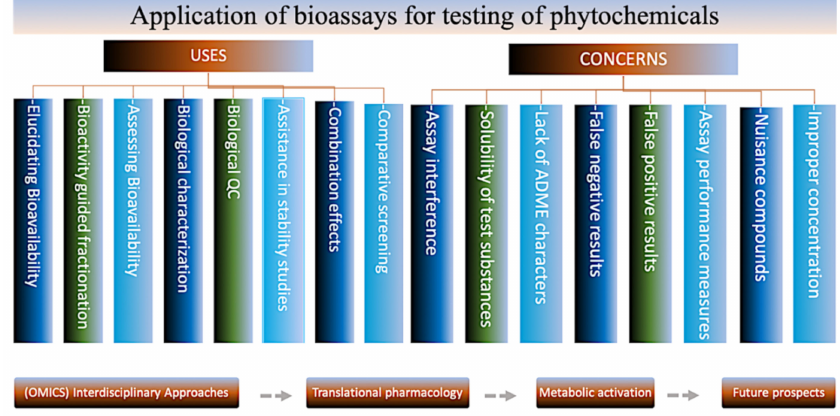
Figure 1. Bioassays for testing Phytochemicals—Uses and